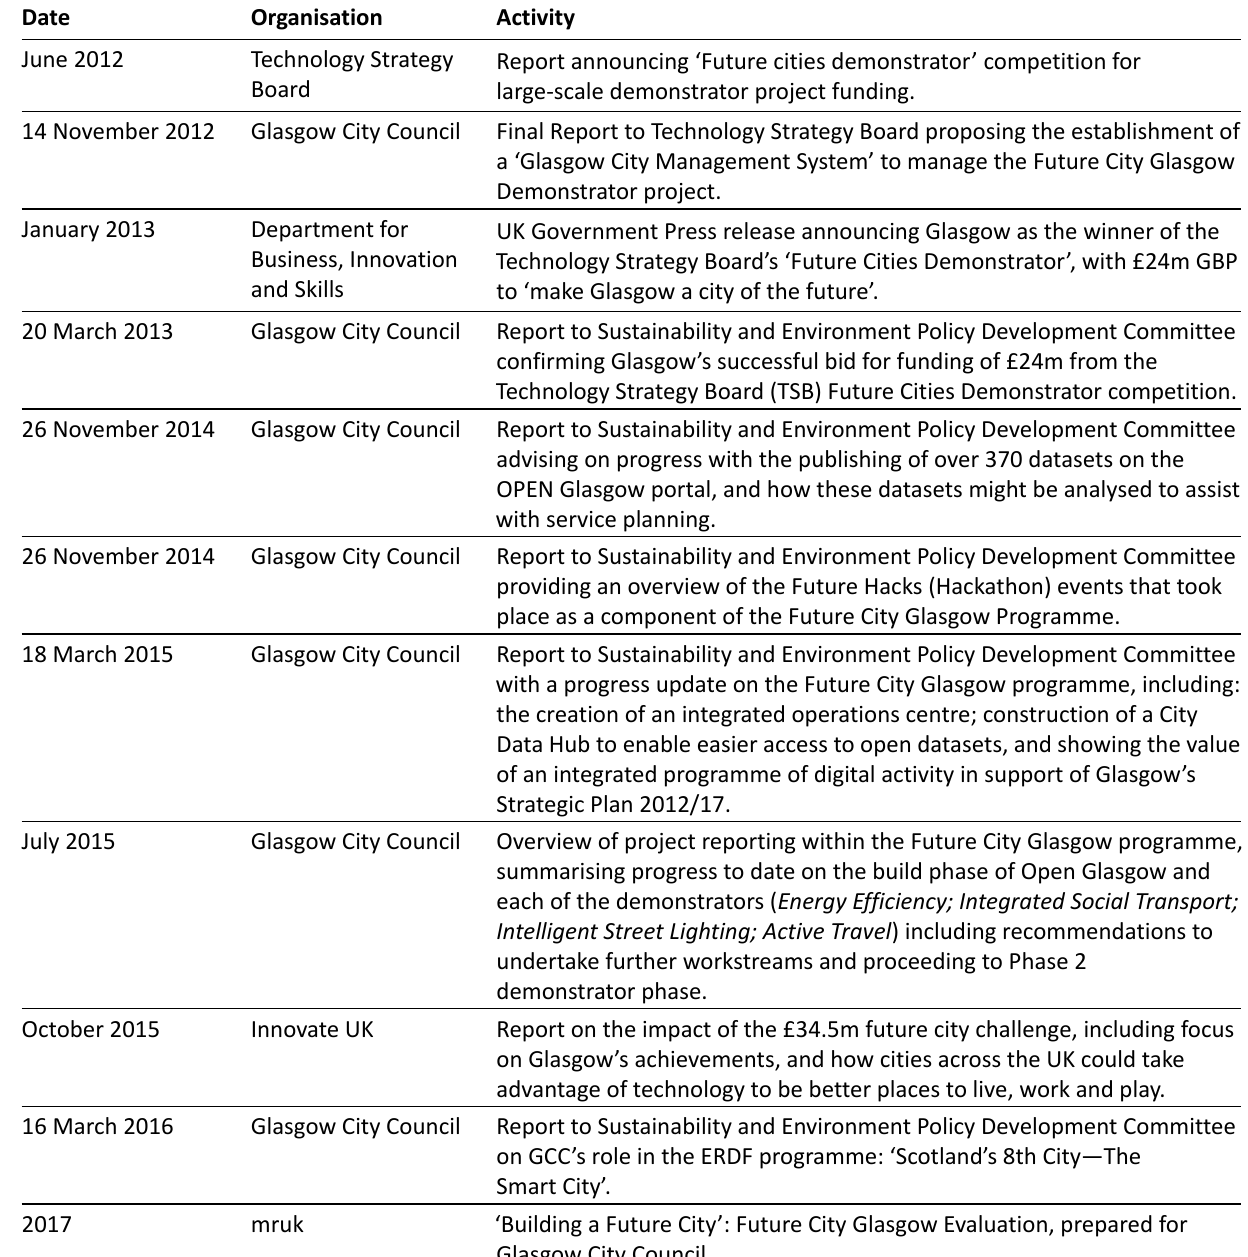
Table 1. Timeline: Future City